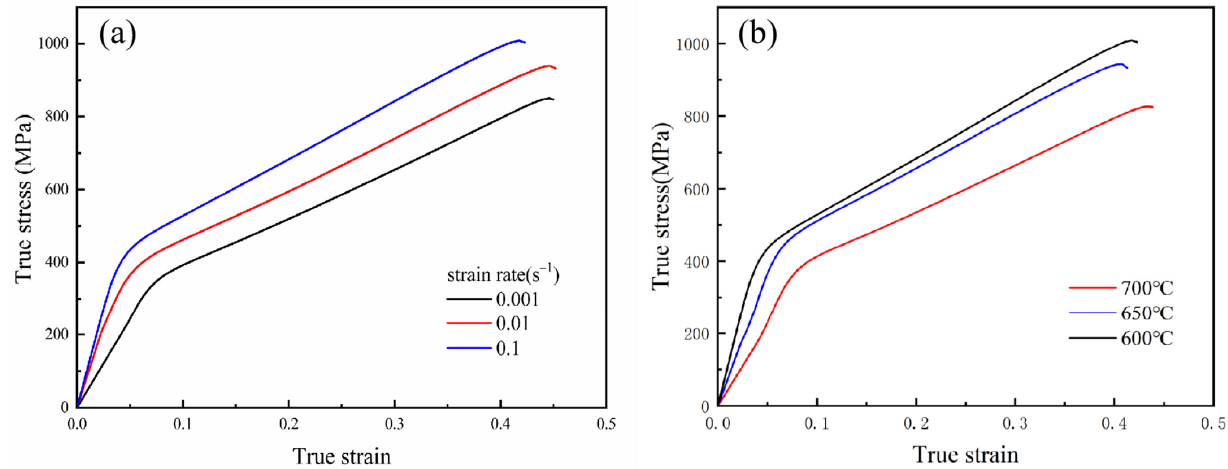
Figure 4. True stress—strain curves of CHN327 alloy at ( a ) different strain rates at 600 ◦ C and ( b ) different temperatures at 0.1 s − 1 .